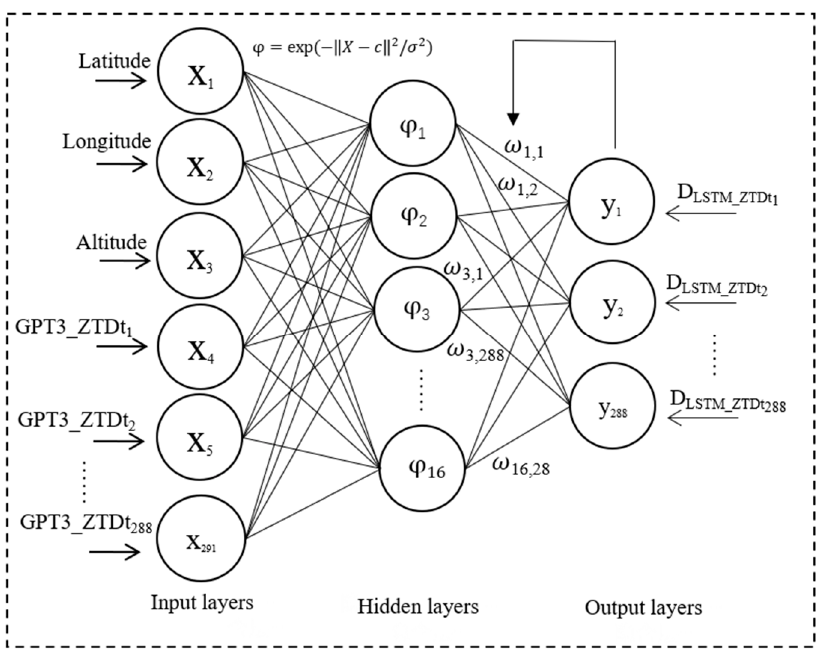
Figure 7. Structure of RBF model.